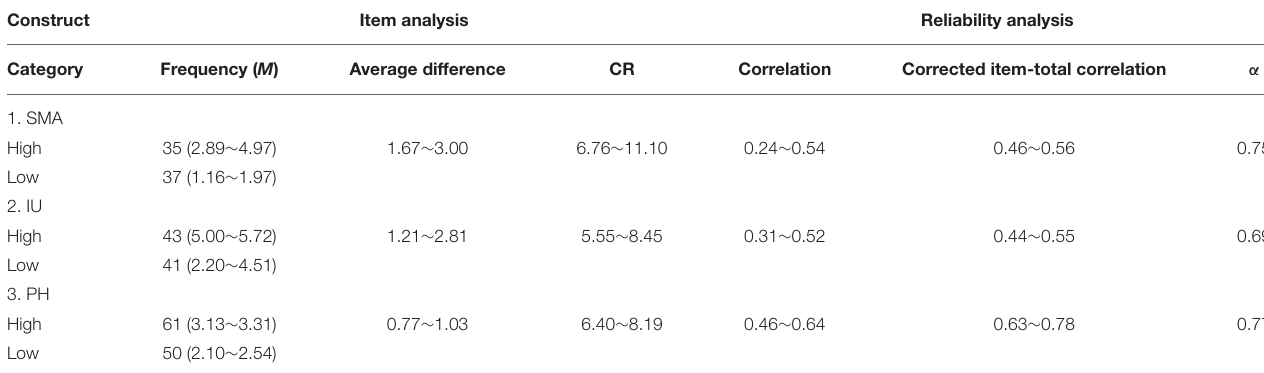
TABLE 1 | Item and reliability analysis ( N =